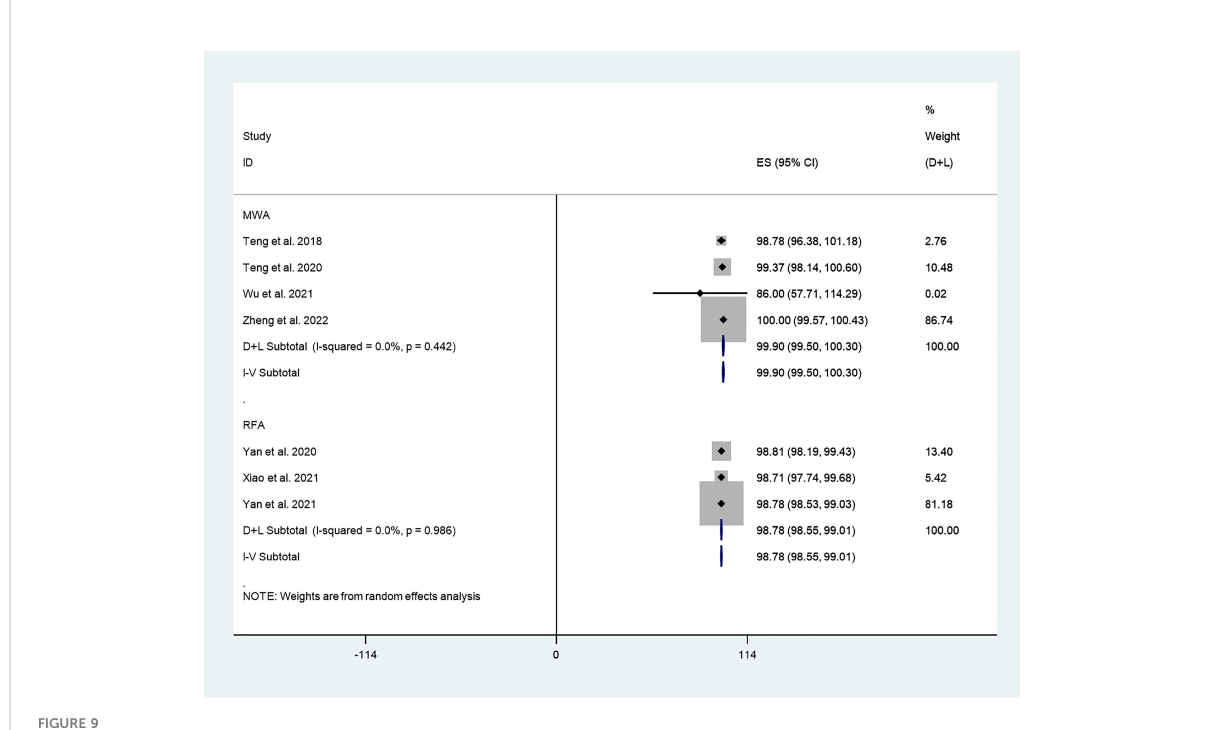
FIGURE 9 VRR after different thermal ablation modalities at 3-year follow-up.